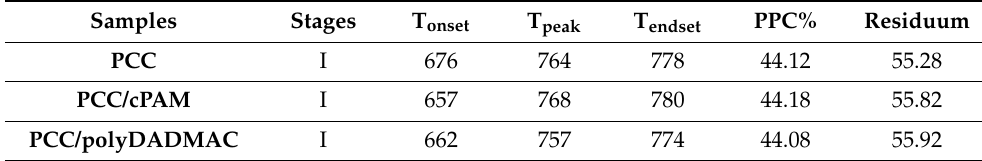
Figure 3. TG ( a ) and DTG ( b ) curves of PCC (black) PCC/polyDADMAC (blue) and PCC/cPAM (red). Thermogravimetric characteristics of the samples are presented in Table 2. Table 2. Thermogravimetric characteristics of the samples .